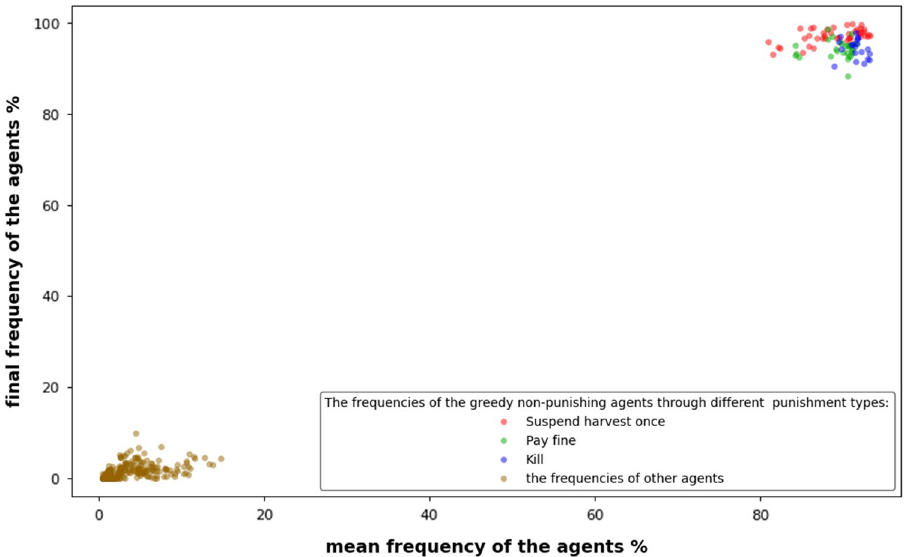
Figure 4. In the upper right, the frequencies of the greedy non-punishing agents through different experiments on three types of punishment: (1) Suspend harvest once (red dots). (2) Pay fine (green dots). (3) Kill (blue dots). The final frequencies of greedy non-punishing agents were above 90% in most runs (except one run for pay fine type was 88%). The mean frequencies of greedy non-punishing agents were above 80% for all runs. In the lower left, the frequencies of the other agents (brown dots): (1) Sustainable, punishing. (2) Sustainable, non-punishing. (3) Greedy, punishing.